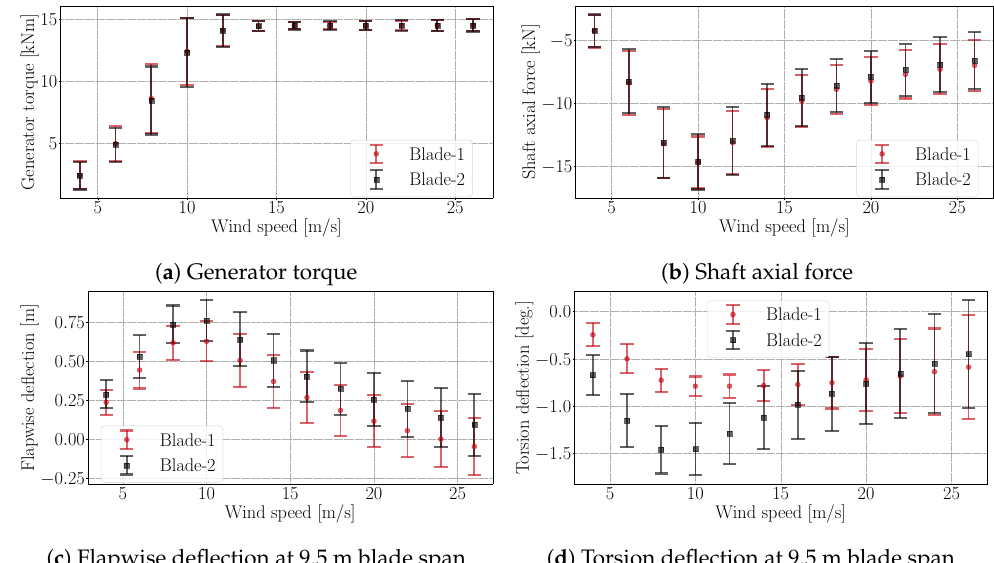
Figure 17. Mean and standard deviation values for generator torque, shaft axial force, flapwise and torsion deflections at 9.5m blade span for